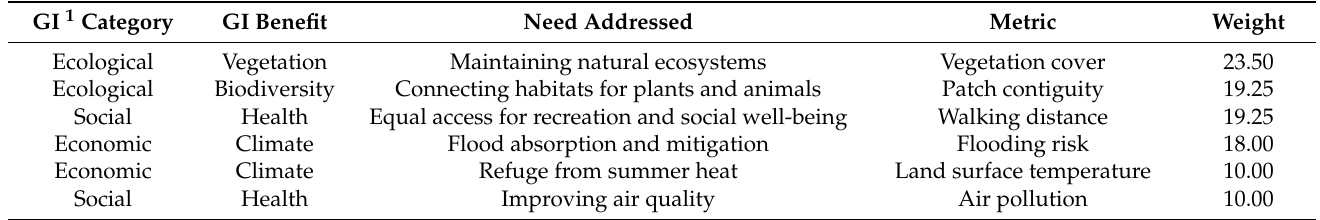
Table 1. Benefits weighting of importance determined during a stakeholder engagement workshop with representatives from private practitioners and City of Tshwane officials.